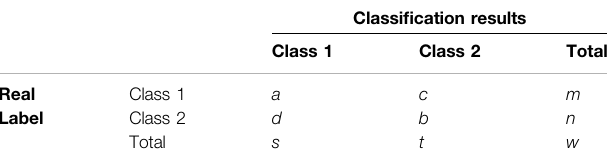
TABLE 1 | Confusion matrix of the two-category